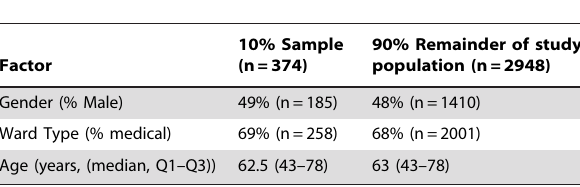
Table 7. Comparison of demographics of patients in 10% sample with the remainder of the study